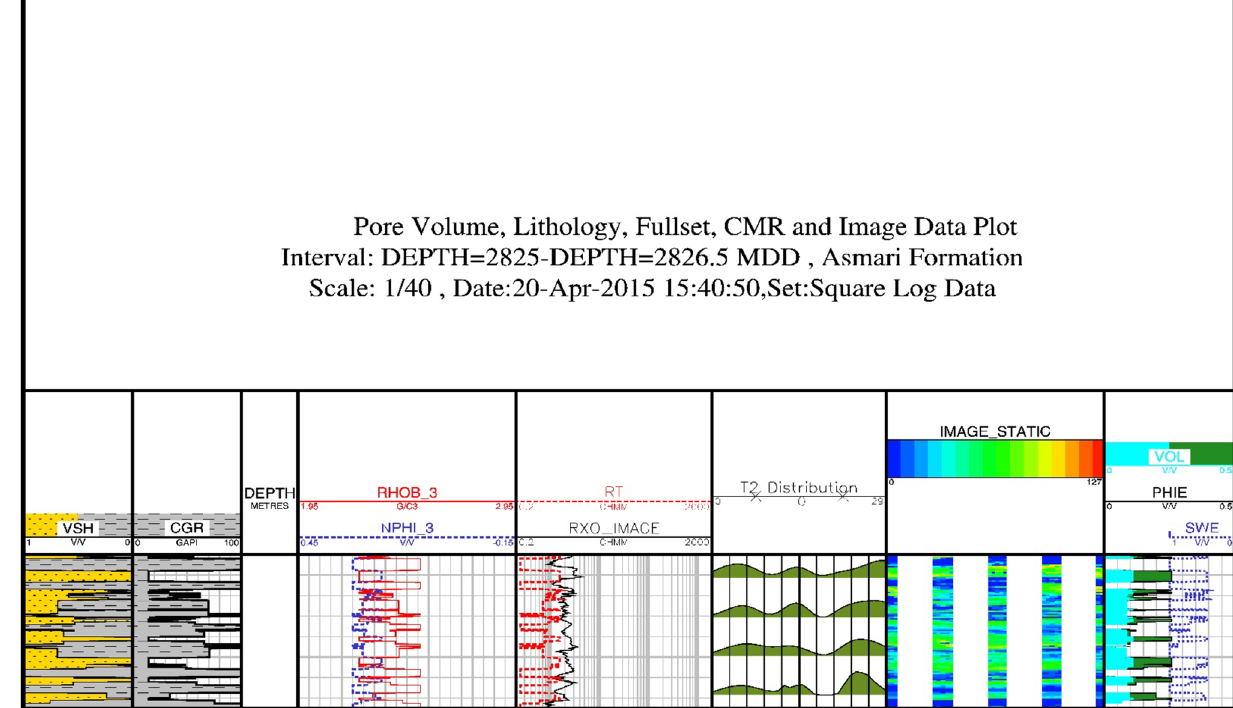
Fig. 13 Square logs results